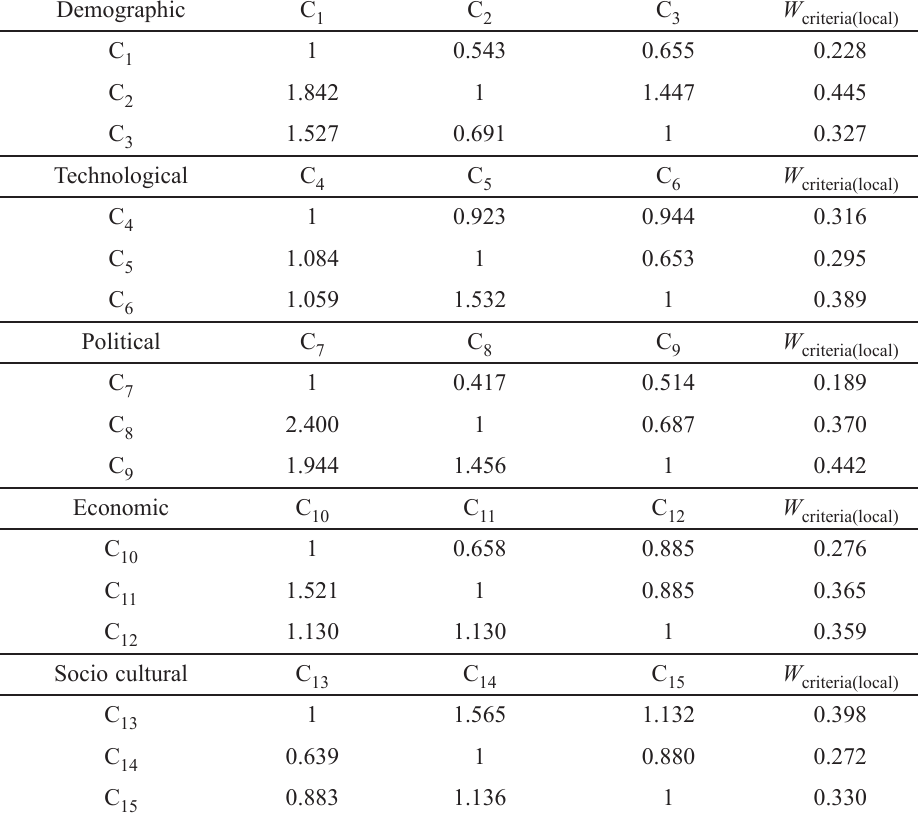
Table 5. Pair-wise comparison matrix and weights for each